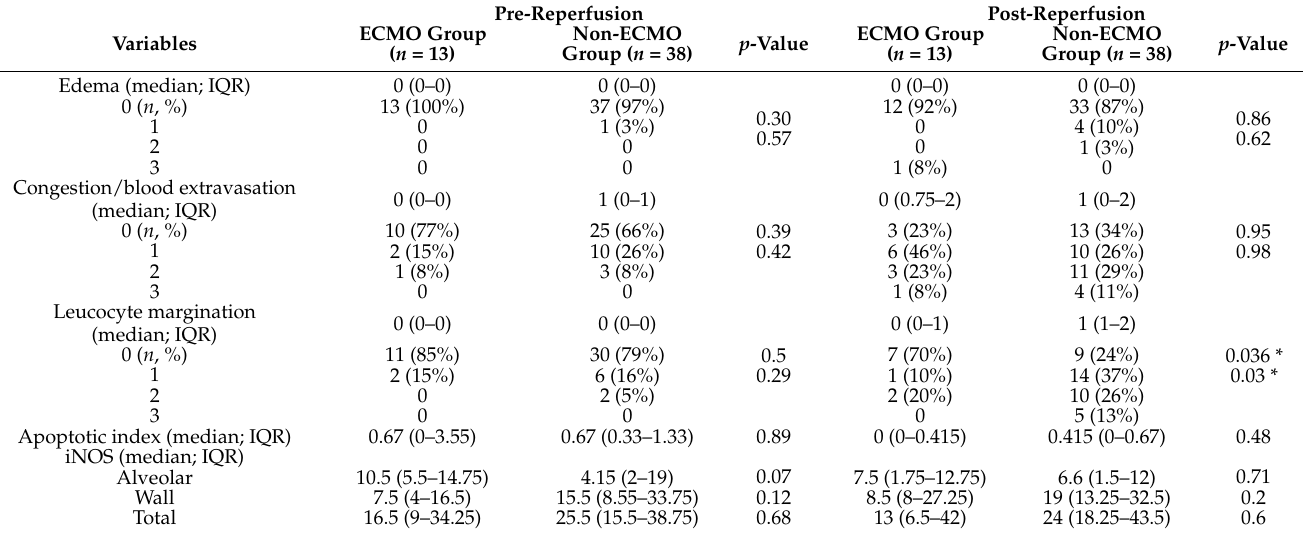
Table 3. Donor histological findings: descriptive statistics. Continuous data are reported as medians (I, III quartiles); categorical data are reported as percentages and absolute frequencies. Wilcoxon-type tests were performed for continuous variables, and Pearson chi-square tests were performed for